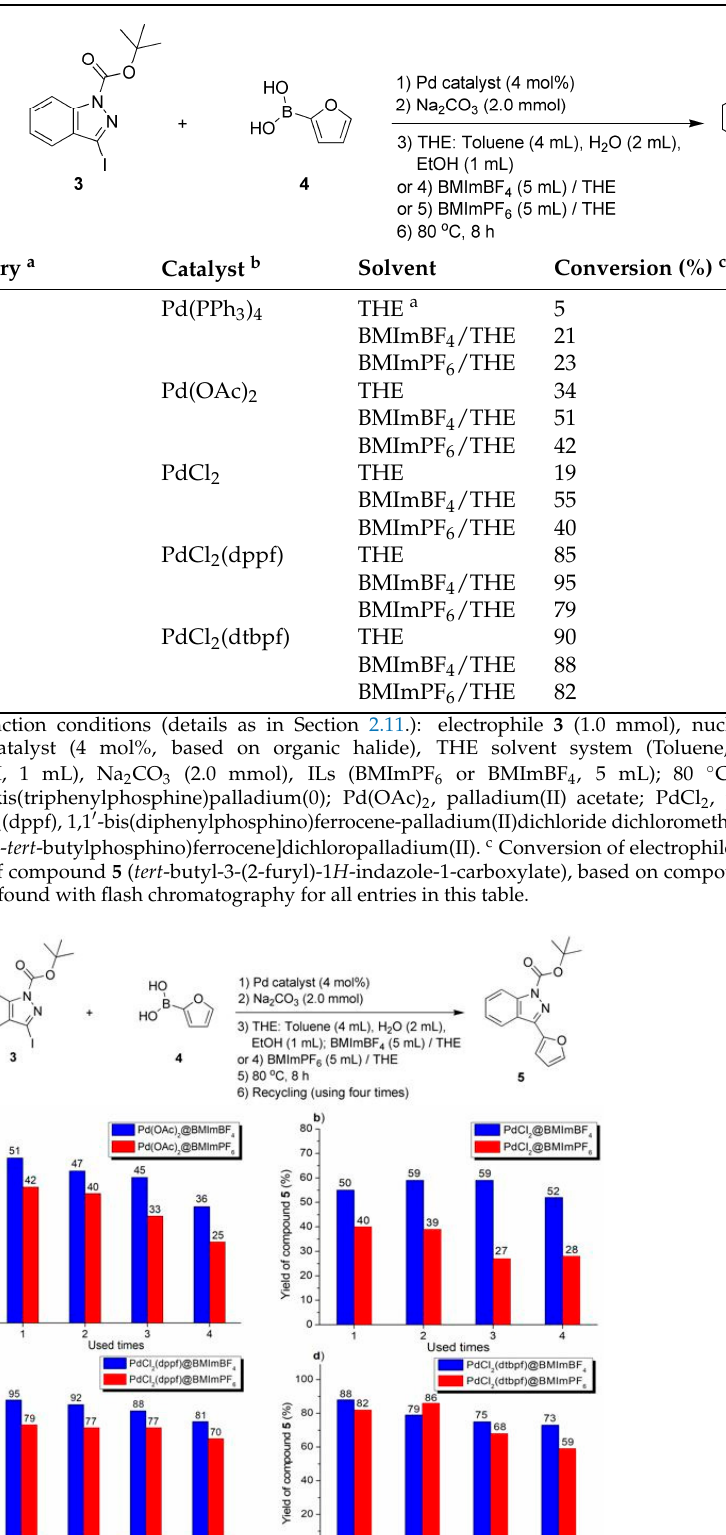
on tert -butyl), 1738 (vs, C=O), 1614 (m, C=N), 1510 (m, furyl), 1422 (m, furyl), 1374 (vs, C- Table 1. Catalytic Suzuki–Miyaura cross-coupling of compounds 3 with 4 . Table 1. Catalytic Suzuki–Miyaura cross-coupling of compounds 3 with 4 .